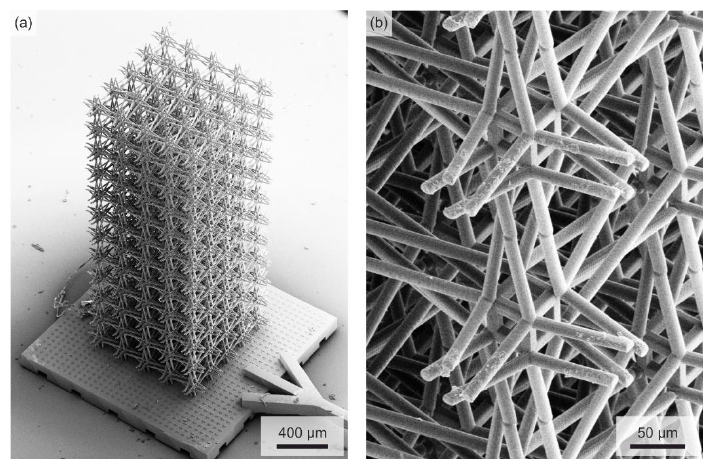
Figure 4. Selected oblique-view electron micrographs of a 3D chiral cubic polymer metamaterial sample manufactured by standard 3D laser micro-printing, following the blueprint illustrated in Figure 1. ( a ) Total view onto one metamaterial sample with N x × N y × N z = 5 × 5 × 12 unit cells and the bottom sample holder. Here, we use no plate at the top. ( b ) Zoom-in, showing the intricate interior composed of sets of twisted rods.